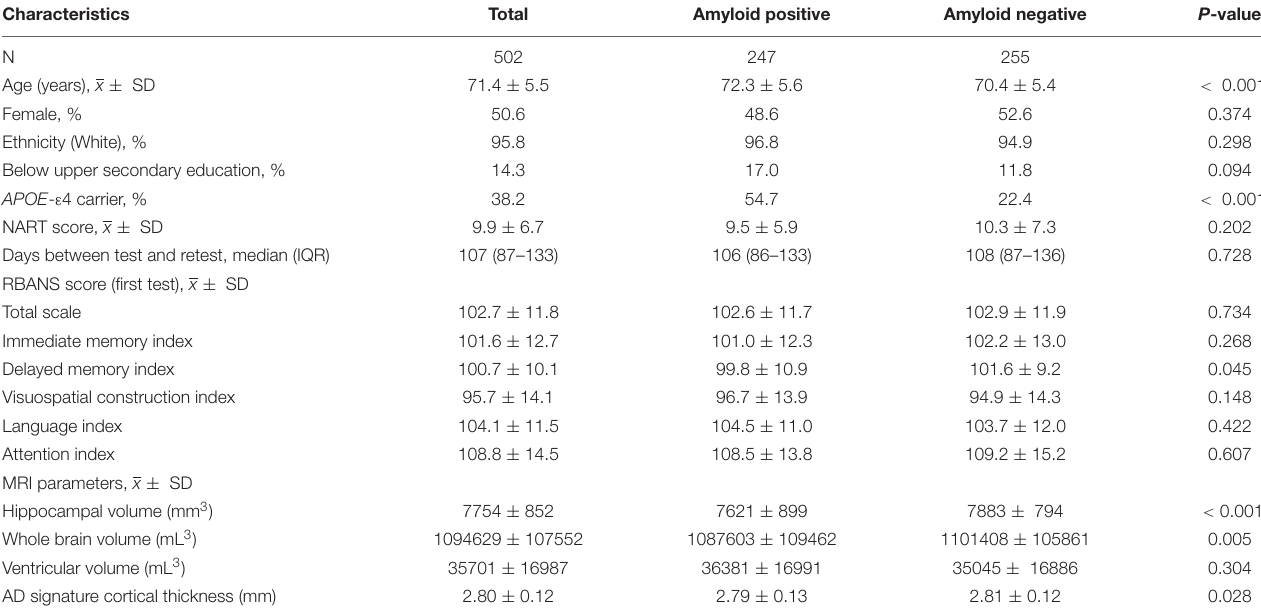
TABLE 1 | Population characteristics by amyloid status ( N =